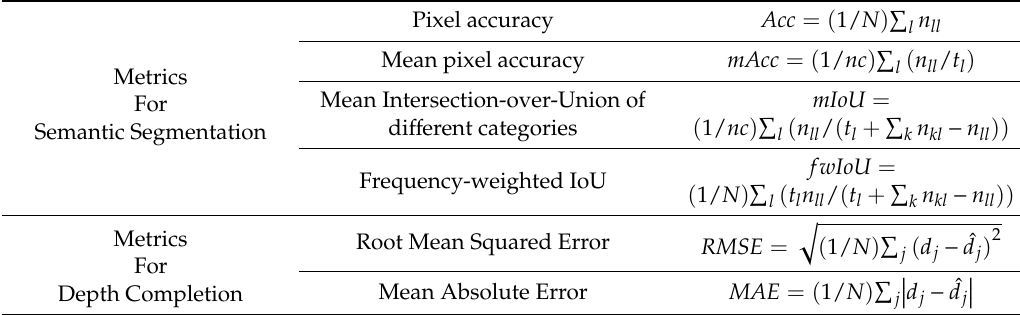
Table 1. Evaluation